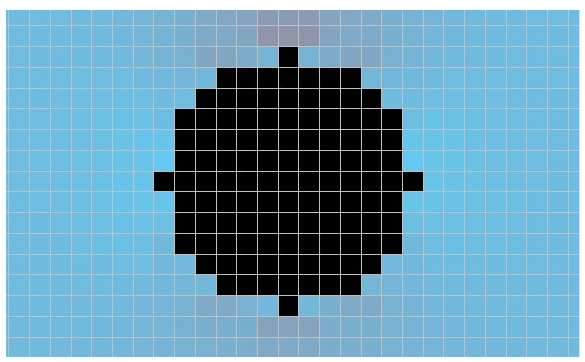
Figure 4. Example: laser spot visualization.